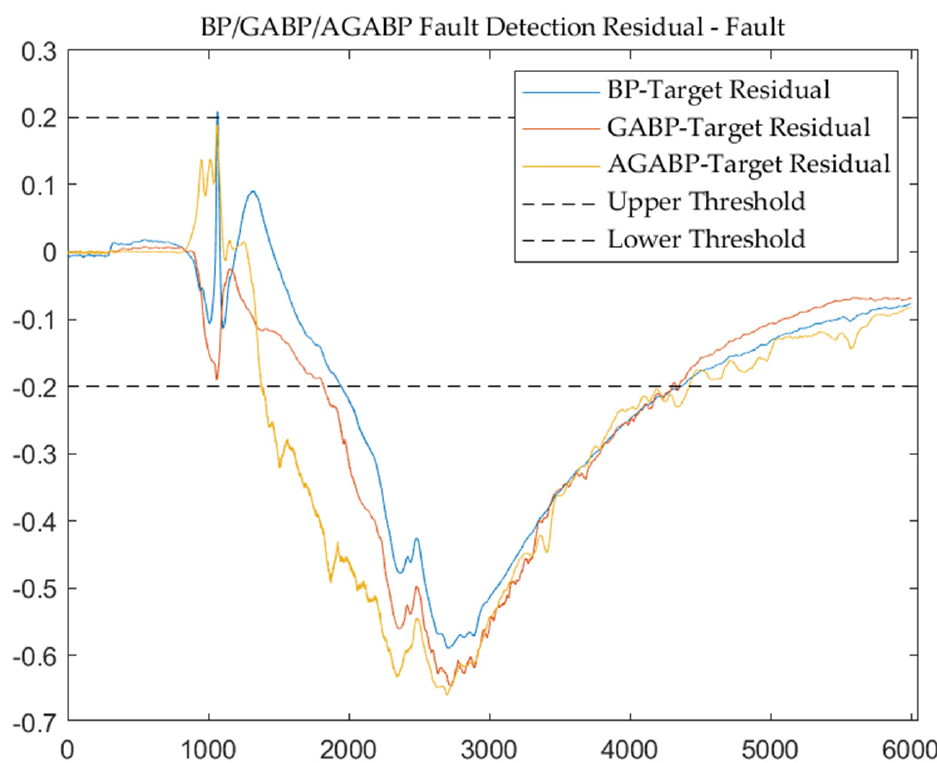
Figure 11. The output residual of the three models—fault.